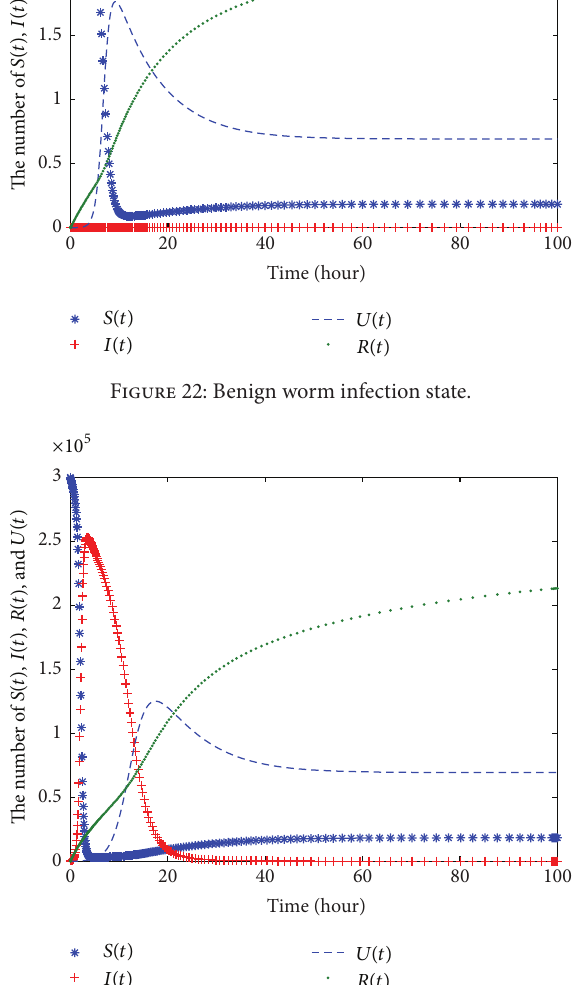
Figure 23: Interaction infection